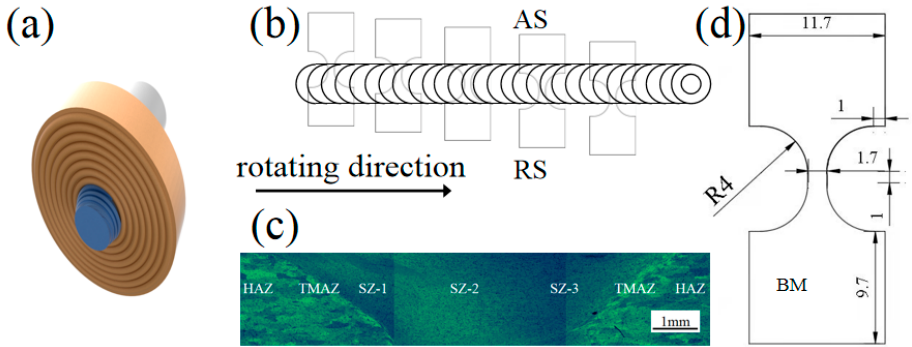
Figure 1. ( a ) Shape of pin tool; ( b ) Sampling position of tensile sample; ( c ) Section optical morphology of HRS-SFSP and ( d ) Size of tensile sample.